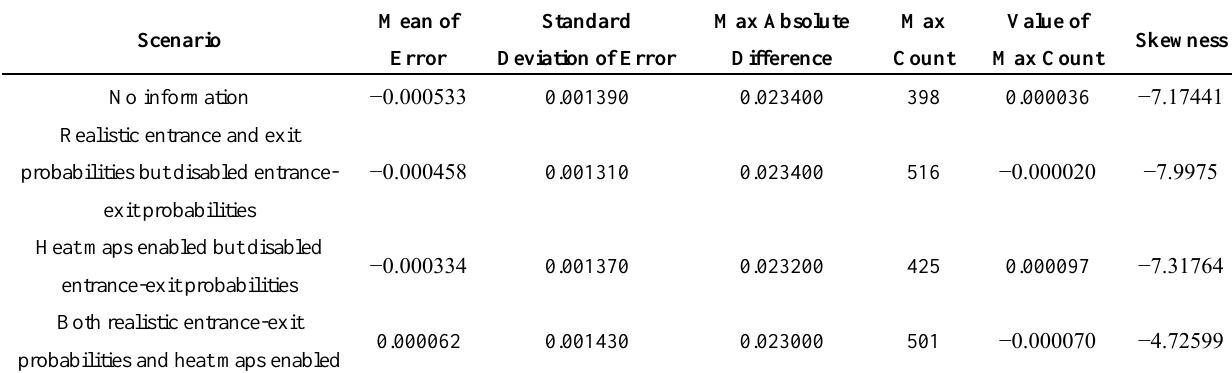
Table 3. Summary statistics from the different